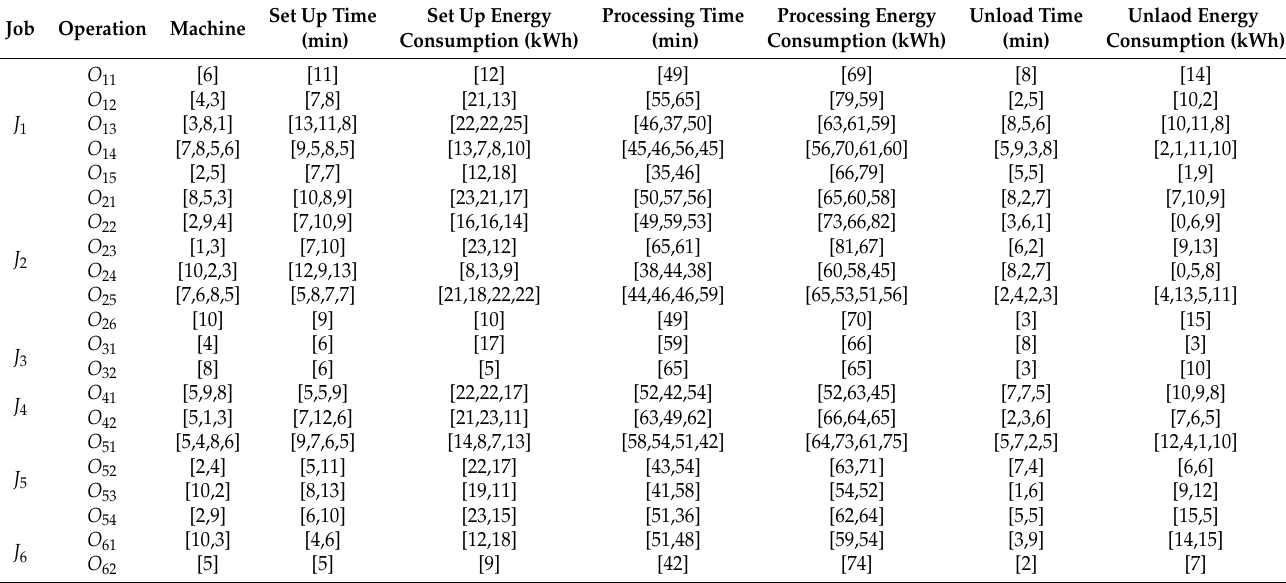
Table 10. The job shop information of Instance